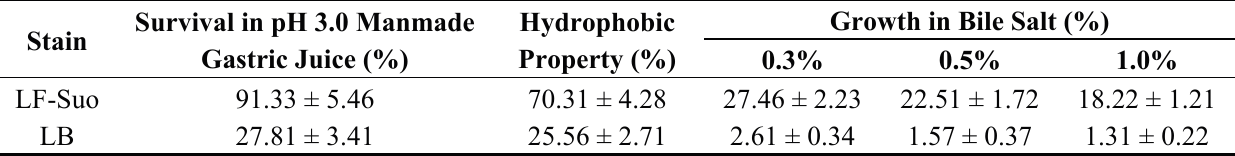
Lactobacillus fermentum Suo